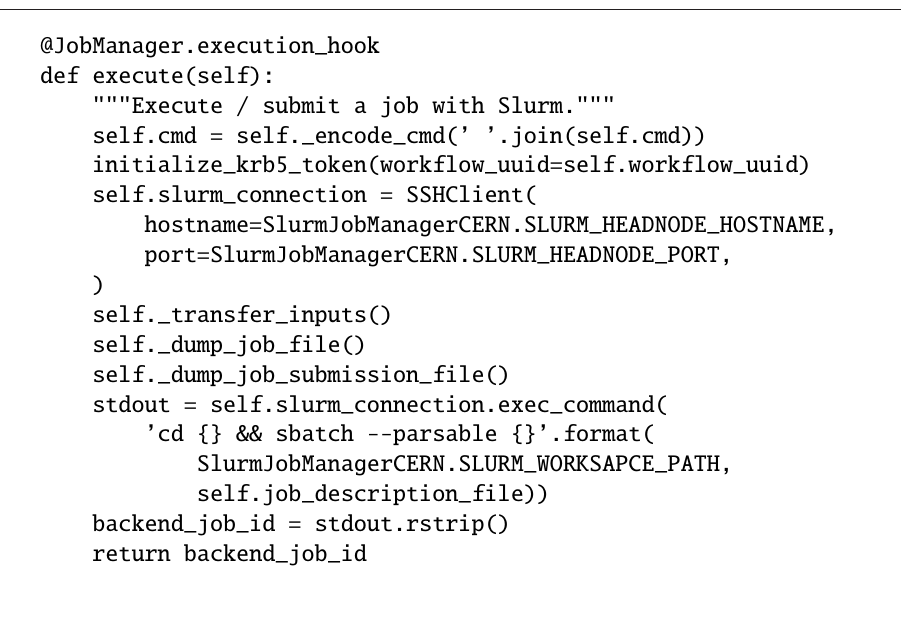
Figure 4. The Slurm job submission code example consists of encoding executable command to ensure escaping of special shell characters, Kerberos token initialization, establishing an SSH connection, transferring inputs, generating job submission files, and submission of a job. Implements execute() method of the abstract JobManager class presented in Figure